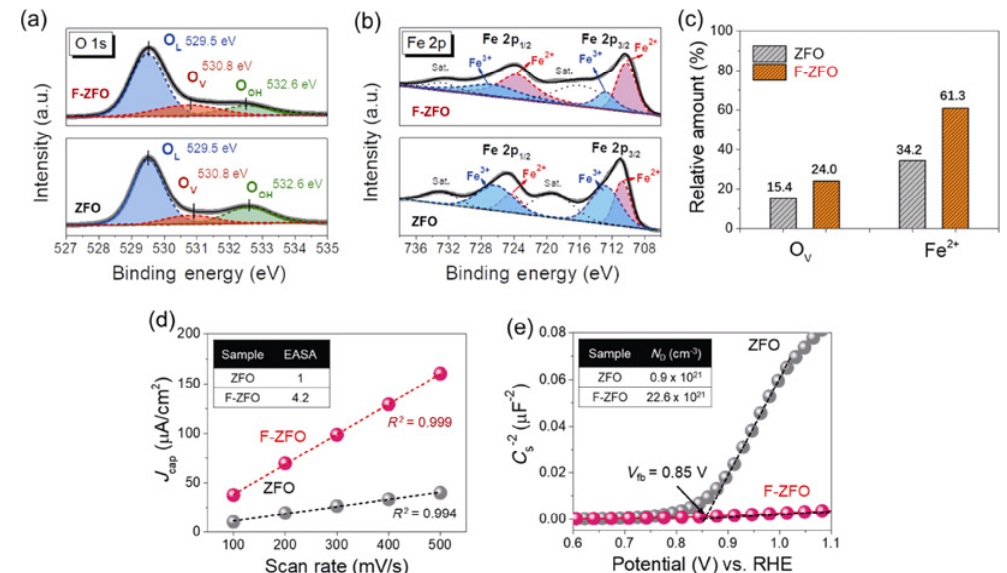
Fig. 2 Surface defects, relative surface area, and carrier concentration analyses. XPS spectra of (a) O 1s and (b) Fe 2p. (c) Relative amounts of oxygen vacancy and Fe 2+ . O L : lattice oxygen. O V : oxygen vacancy. Relative amount of [O V ] = [O V ]/ [O L + O V ] and [Fe 2+ ] = [Fe 2+ ]/[Fe 3+ + Fe 2+ ]. (d) Relative electrochemical active surface area (EASA) and (e) Mott–Schottky (MS) analysis of ZFO and